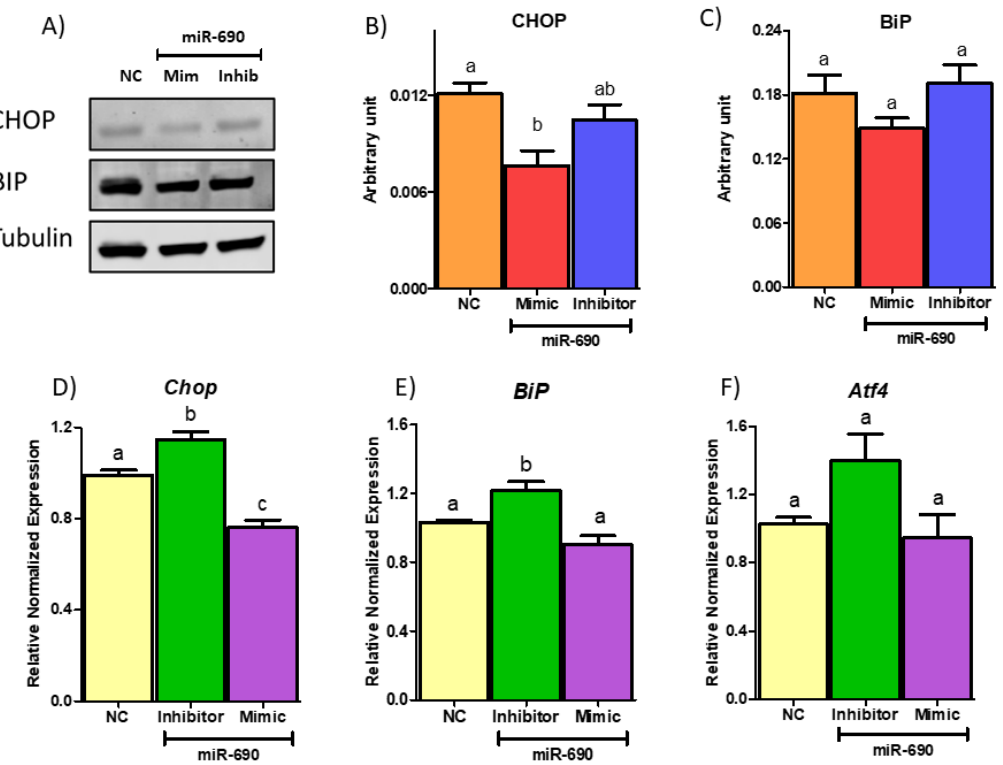
Figure 9. E ff ects of targeting mitogen-activated protein kinase kinase 3 ( Map2k3 ) by miR-690 on ER stress markers. ( A ) Western blot image of protein amounts of C / EBP homologous protein (CHOP) and binding immunoglobulin protein (BIP). Mir-690 Mimic significantly reduced CHOP expression compared to negative control (NC) group, but no changes were observed with inhibitor. BIP protein amounts were unchanged among NC, miR-690 mimic and inhibitor groups. ( B ) Quantification of CHOP protein normalized to Tubulin. ( C ) Quantification of BIP protein normalized to Tubulin. ( D ) Gene expression of Chop . miR-690 inhibitor significantly induced Chop expression, whereas mimic treatment reduced Chop expression as expected compared to NC group. ( E ) miR-690 inhibitor treated group had significantly increased mRNA level of BiP compared to NC group, yet no changes were observed among mimic and NC treated groups ( F ) No di ff erences were observed in activating transcription factor 4 ( Aft4 ) gene expression with treatments of miR-690 inhibitor or mimic compared to NC group. Common letters on the error bars indicate no significance (e.g., “a” is significantly di ff erent from “b” and “ab” indicates no significance compared to “a” and “b”). Data are presented as mean ± SEM ( p < 0.05). ( n = 4).